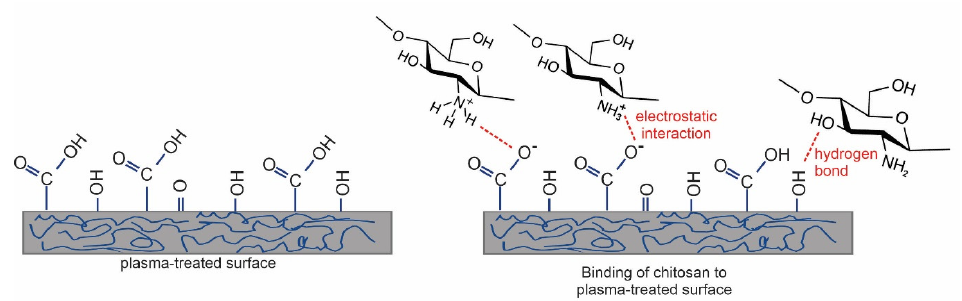
Figure 3. Different types of noncovalent interaction of chitosan with the plasma-treated surface [81].